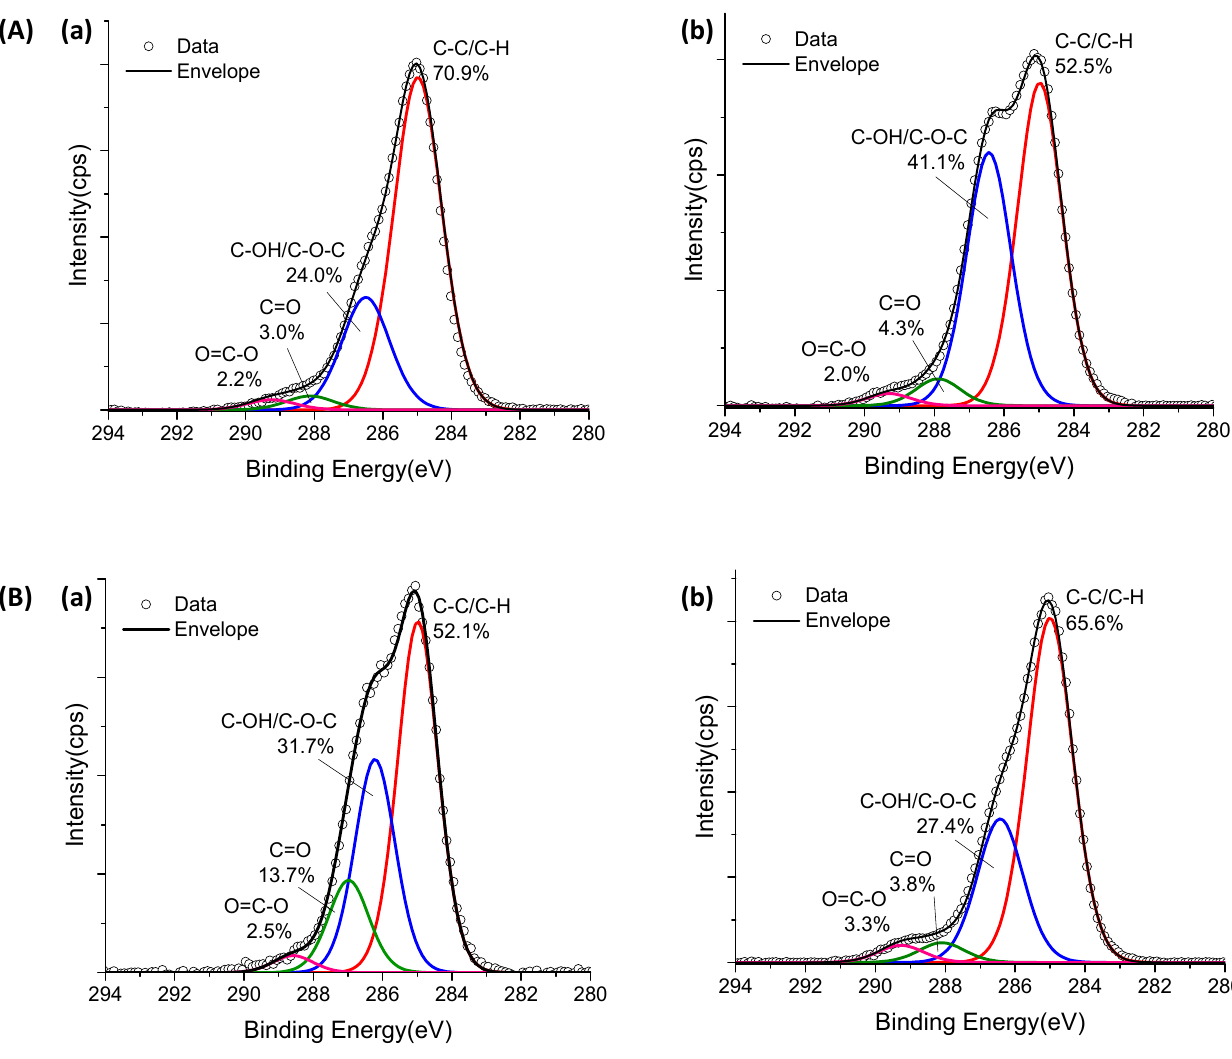
Figure 11. XPS analysis of C 1s region of ( A ) CMC-250:PVA and ( B ) CMC-700:PVA hybrids with CA/polymer content ( a ) 0% and ( b ) 25%.